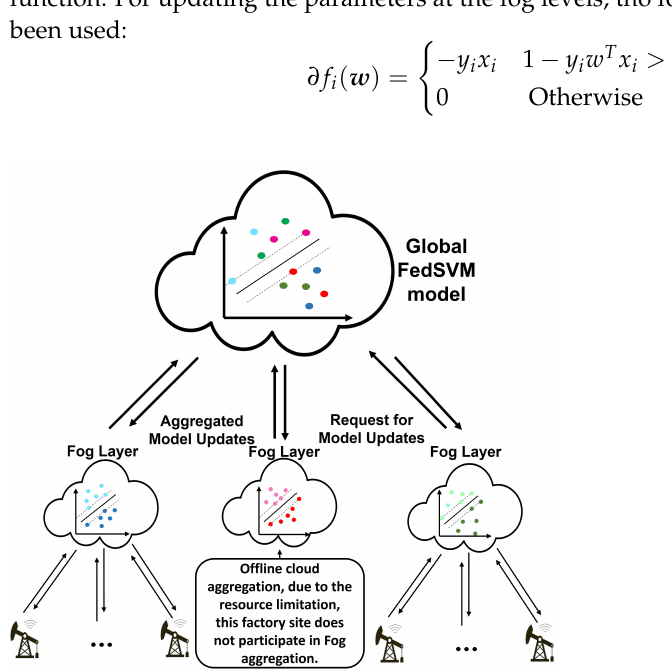
Figure 3. FedSVM